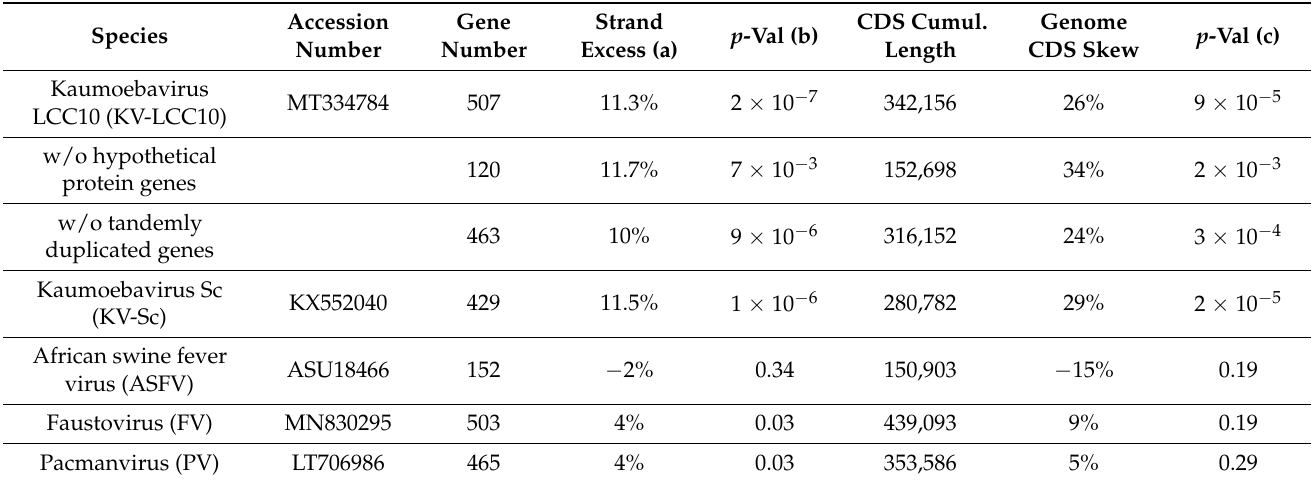
Table 2. Gene strand bias in KV and virus